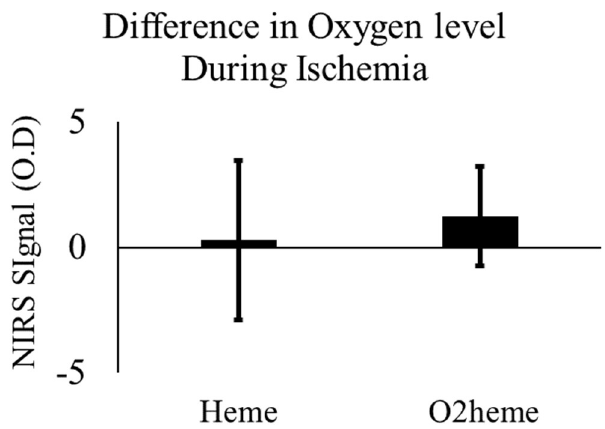
Figure 3. The change in O 2 heme and Heme signals before and after stimulation during the 5 min of ischemia with prior stimulation. There was no significant difference, p > 0.05. Values are means with the 95% confidence intervals.